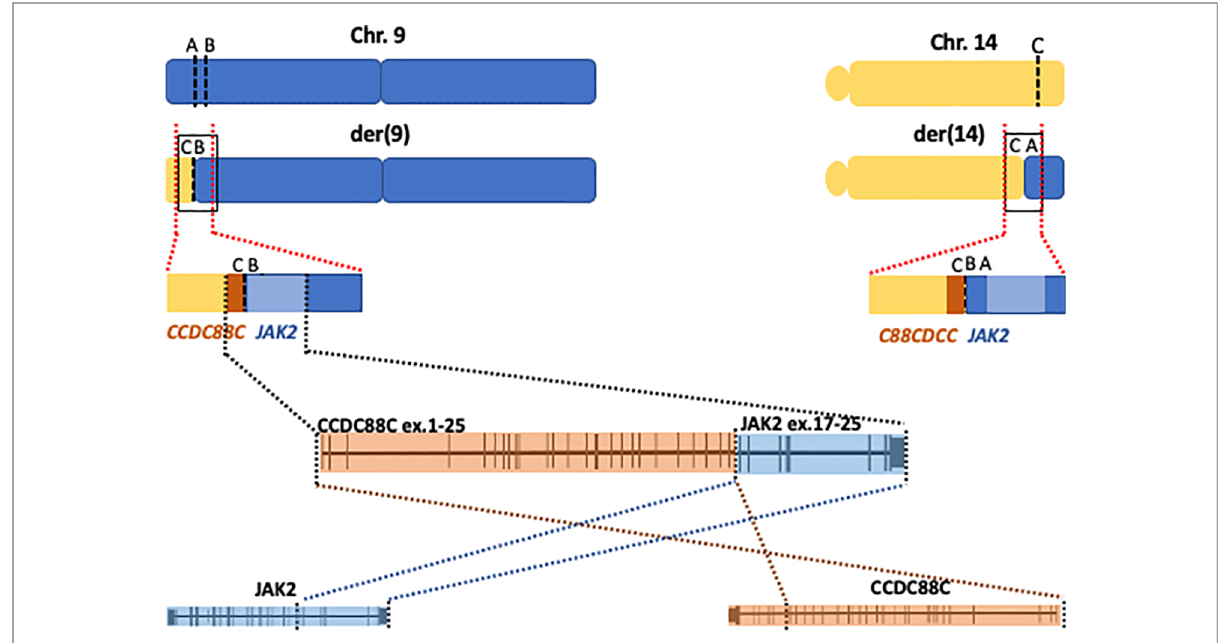
FIGURE 2 Cartoon showing a schematic representation of chromosomes 9 (blue) and 14 (yellow) at the derivative chromosomes 9 and 14 (upper panel), the black squares mark the junctions. Middle cartoon represents a blow up of the junctions illustrating the creation of the fusion gene on derivative chromosome 9 (der9). The lower panel represents a magni fi cation of the fusion gene showing exons 1 – 25 in CCDC88C joined to exons 16 – 25 in JAK2